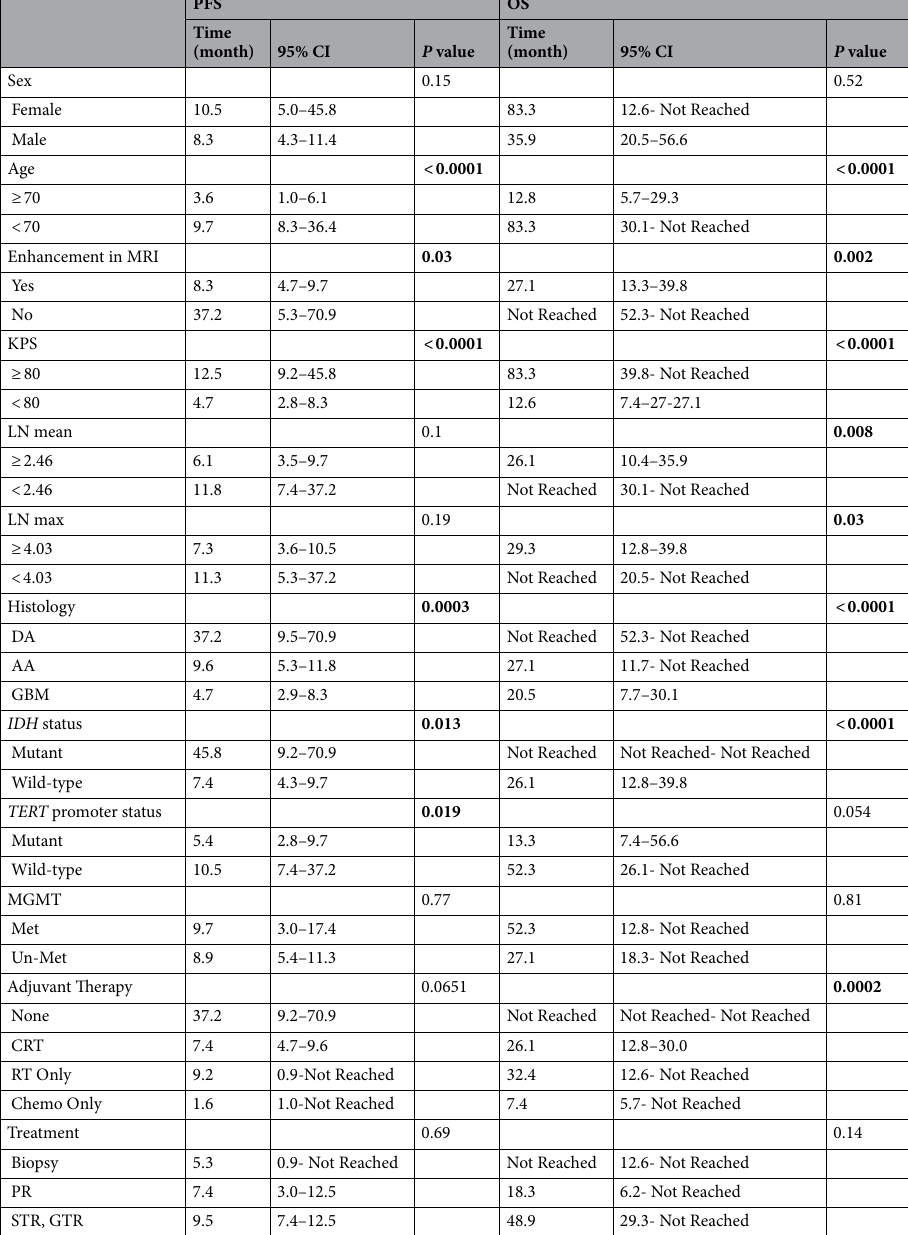
Table 2. Prognostic factors for PFS, and OS in the univariate analyses. P values in bold font are statistically significant. MRI magnetic resonance imaging, KPS Karnofsky performance status, LN lesion-to-contralateral normal brain tissue, DA diffuse astrocytoma, AA anaplastic astrocytoma, GBM glioblastoma, IDH isocitrate dehydrogenase, TERT telomerase reverse transcriptase, MGMT O 6 -methylguanine-DNA-methyltransferase, Met methylation, CRT chemoradiotherapy, RT radiation therapy, Chemo chemotherapy, PR partial resection, STR subtotal resection, GTR gross total resection, PFS progression-free survival, CI confidence interval, NA not applicable, OS overall